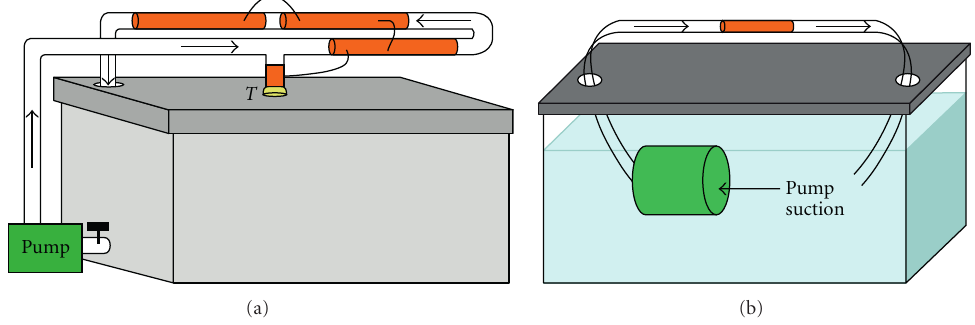
Figure 2: Large and small pipe-loop apparatuses; flow direction is indicated by